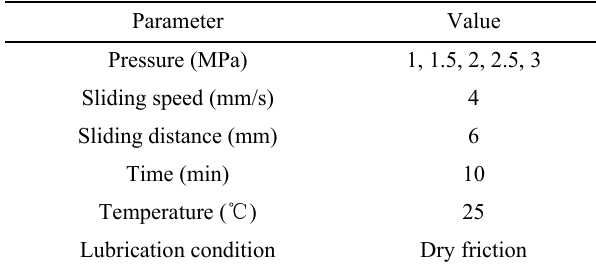
Table 1 Experimental parameters.